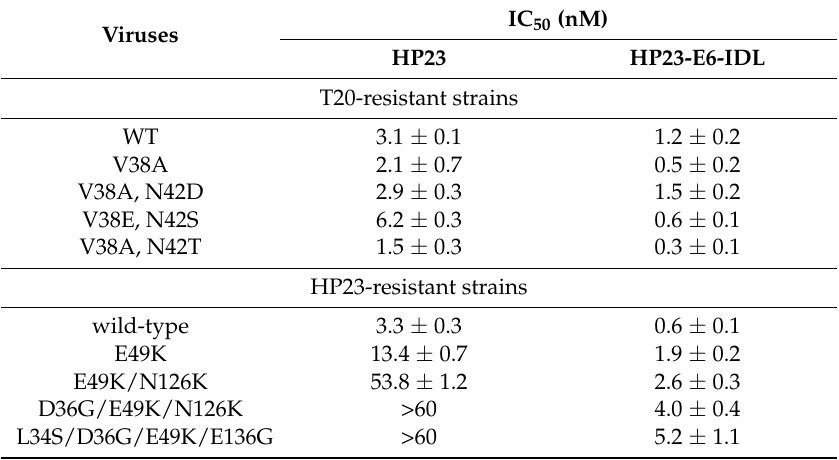
Table 3. Inhibitory activities of HP23 and HP23-E6-IDL against HIV-1 T20- and HP23-resistant